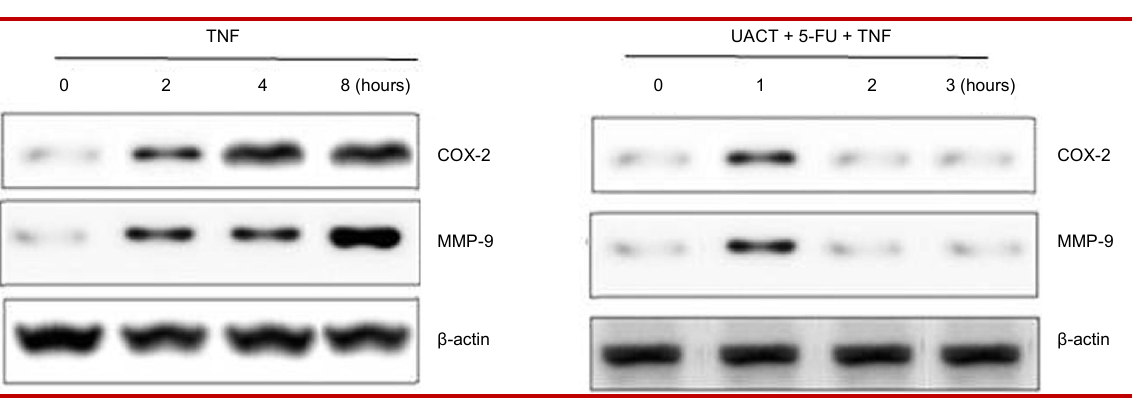
Figure 4: UACT and 5-FU inhibited TNF-induced NF- k B-dependent reporter gene (SEAP) expression H209 cells treated with UACT and 5-FU at 100 nM and 10 nM were transiently transfected with a NF- k B containing plasmid linked to the SEAP gene. After 24 hours in culture with 1 nM TNF, cell supernatants were collected and assayed for SEAP activity. Results are expressed as fold activity over the activity of the vector control